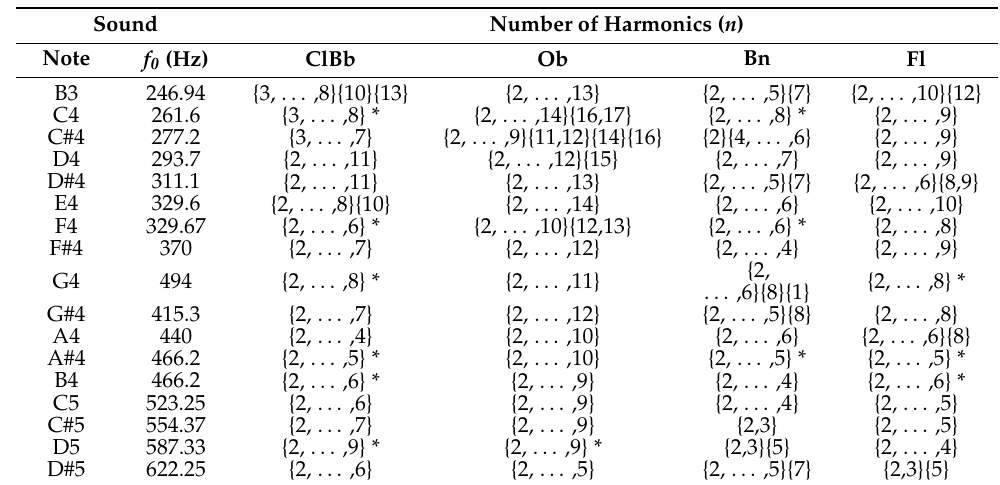
Figure 15. Spectral Signatures for Aerophones: ( a ): Clarinet and Oboe, ( b ): Bassoon and Transverse Flute. Table 1. Set of harmonics depending on the musical sound and the musical